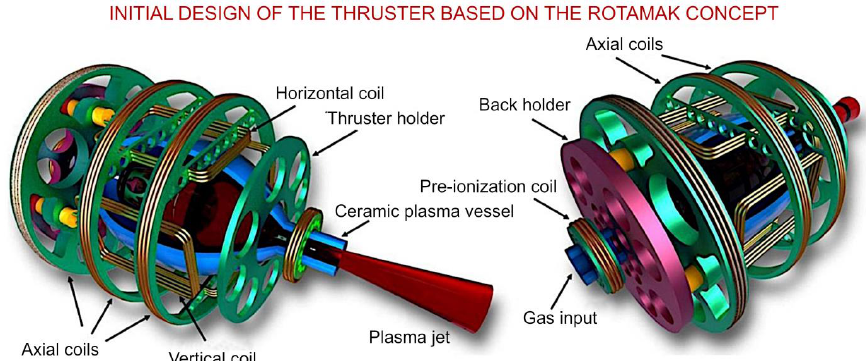
Figure 4. Initial design scheme of the practical thruster based on the Rotamak concept (under development). The design consists of three axial coils and two holders joined with cross-plates to form the main frame, where the plasma vessel is installed. Additional coils, together with gas supply pipes and insulating inserts, are fixed within the frame. Reprinted with permission from Ref. [83]. Copyright 2021, IOP.